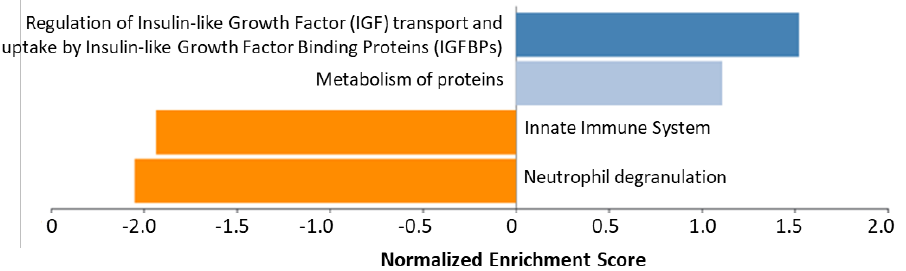
Figure 3. Gene-set enrichment analysis with the differentially expressed proteins after 6-month ther- apy with teriparatide. Orange bars to the left indicate downregulation of the pathway (FDR < 0.05), whereas blue bars to the right are represent upregulating effect on the pathway. Light blue is not significant (FDR > 0.05), whereas dark blue is significant (FDR < 0.05).